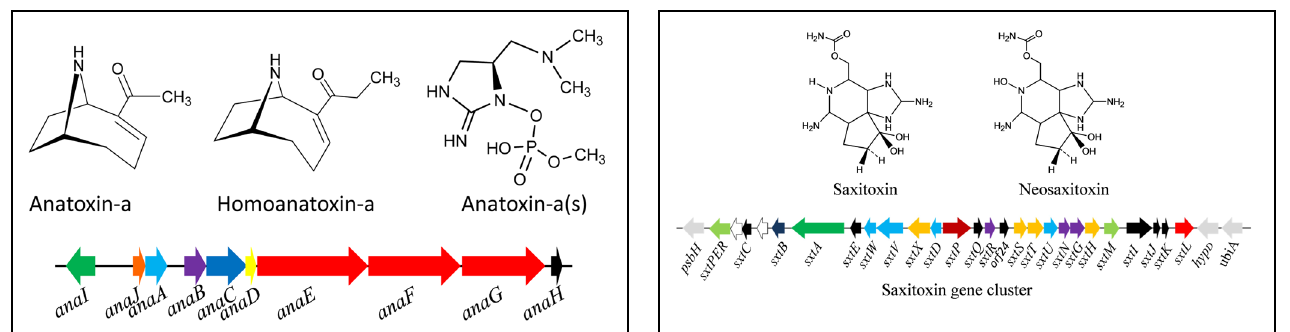
FIGURE 5 | Chemical structure of saxitoxin and its biosynthetic gene cluster in the cyanobacterium Aphanizomenon sp. NH-5. Light green – transporter, white – transposase, black – unknown, dark blue – cyclase, green – polyketide synthase, light blue – oxido-reductase, orange – hydroxylase, dark red – putative regulator, orange – transferase, red – hydrolase (for details, see Kellmann et al., 2008; Mihali et al., 2009; Gene cluster not drawn to